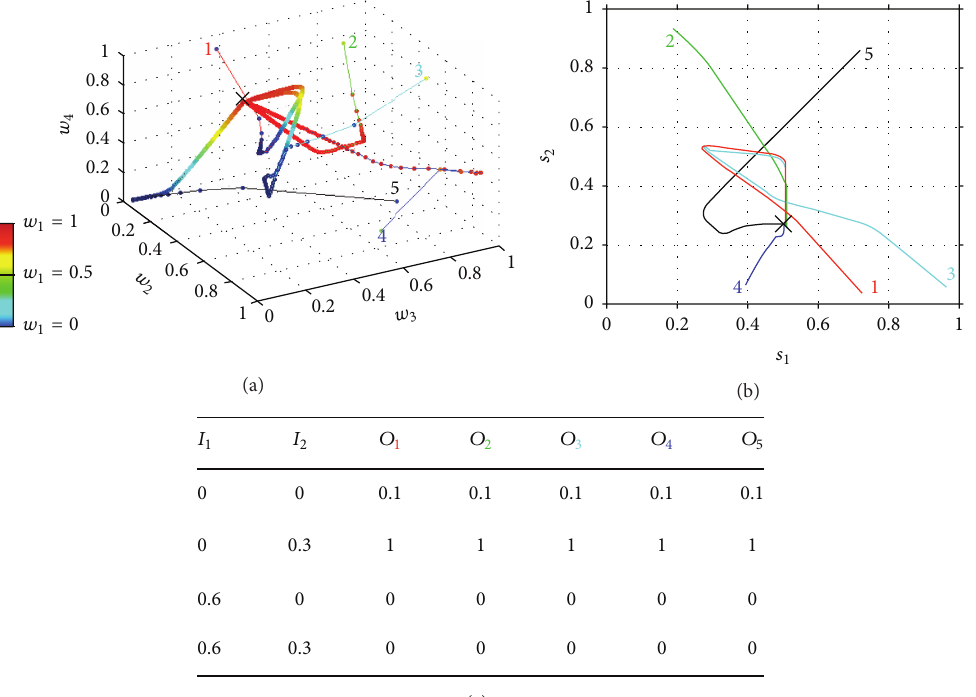
stimulus are given to a subject with specific intensity